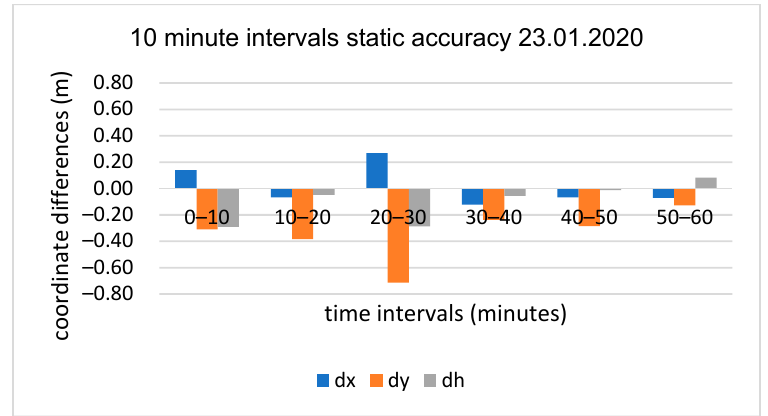
Figure 17. 10 min sub-session positioning results for the third test, baseline OPNT–P30Pro (4 km).